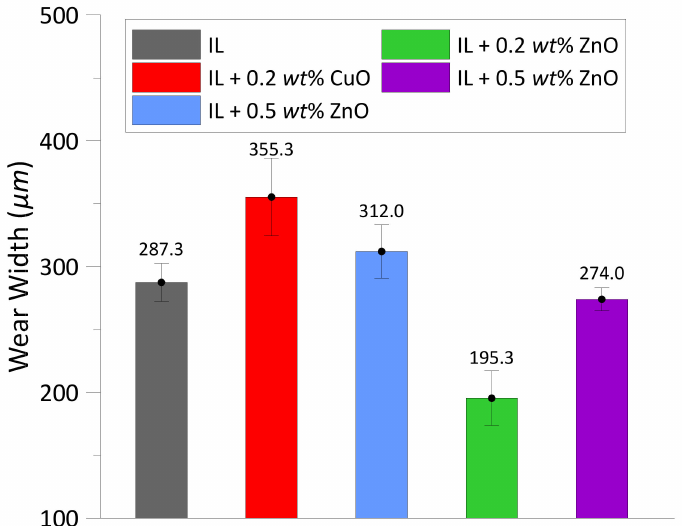
Figure 4. Average widths of wear scars on the disc.